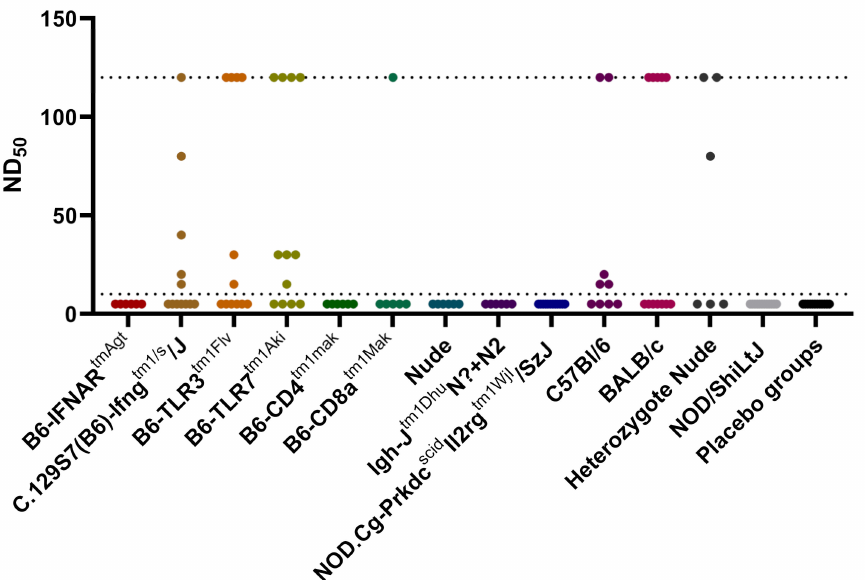
Figure 3. Serum neutralization test results of all mouse strains infected with RVFV and placebo groups: detectable antibody titers in serum samples were measured between 1:10 and 1:120 dilutions. The placebo groups of all mouse strains are summarized for better readability. The detection range is shown as punctuated lines. RVFV: Rift Valley fever